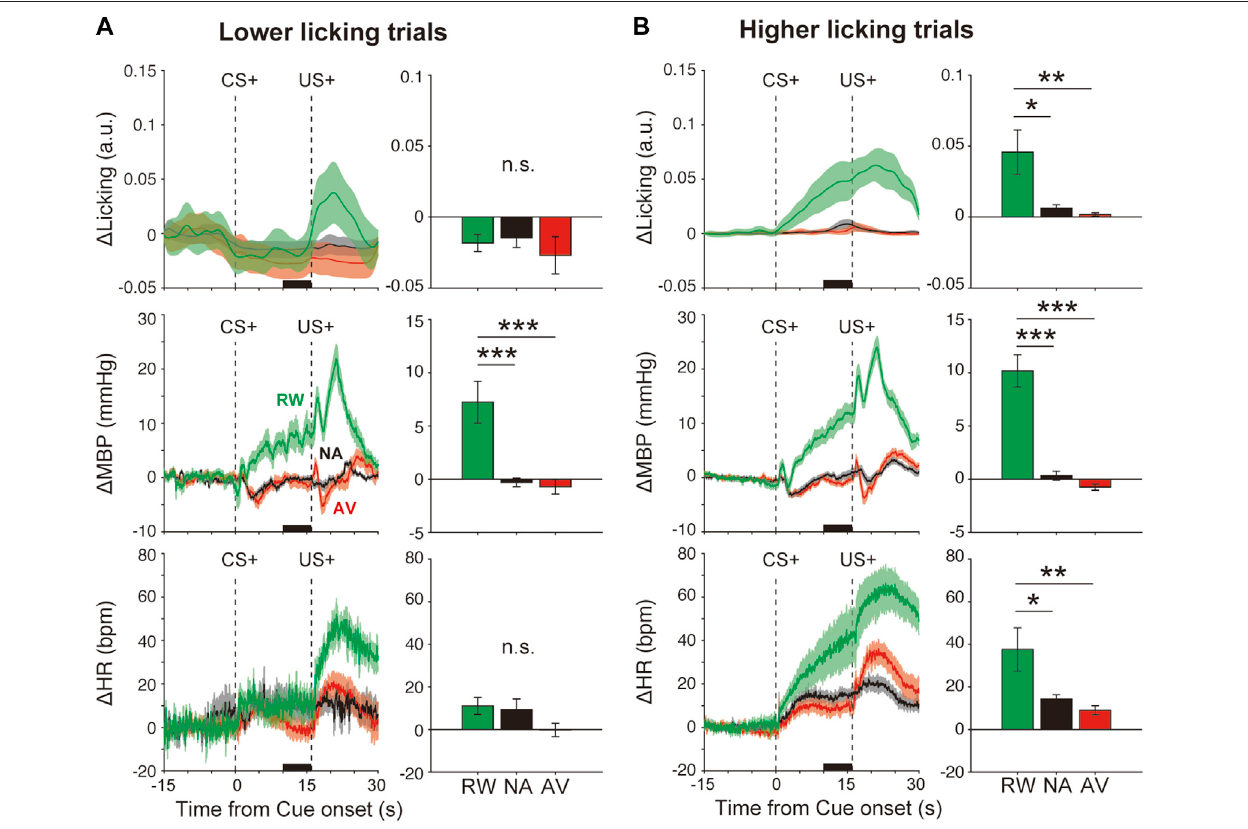
FIGURE 3 | Effects of orofacial licking movements on cardiovascular responses. Average responses and quantitative bar graphs (inset of each fi gure) of licking ( Δ Licking; top panels), mean blood pressure ( Δ MBP; middle panels), heart rate ( Δ HR; bottom panels), and responses to CS+ (left panels) and CS − (right panels) during the reward (RW; green line and bar), neutral (NA; black line and bar), and aversive (AV; red line and bar) condition blocks in trials with a (A) lower-licking group or (B) higher-lickinggroupthanthethreshold(twostandard deviationsfrom thebaseline)during theCS – USinterval. * p < 0.05,** p < 0.01, *** p < 0.001,one-wayanalysis of variance with a Tukey – Kramer post hoc test, and n = 10